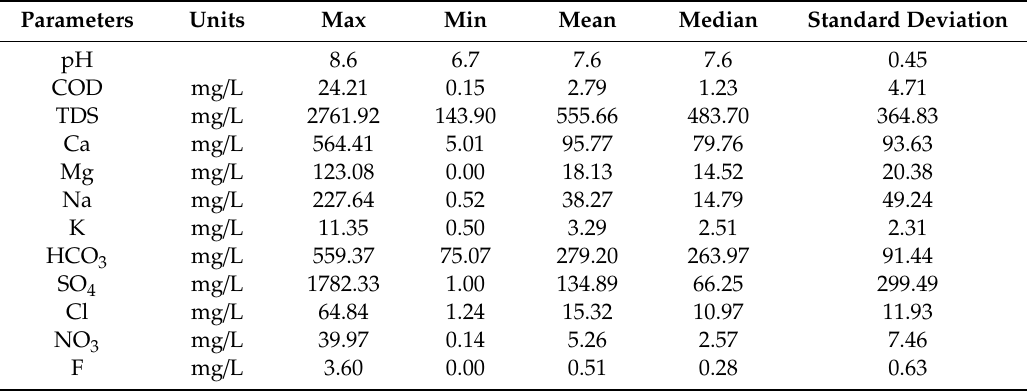
Table 2. Statistical summary of chemical parameters of groundwater